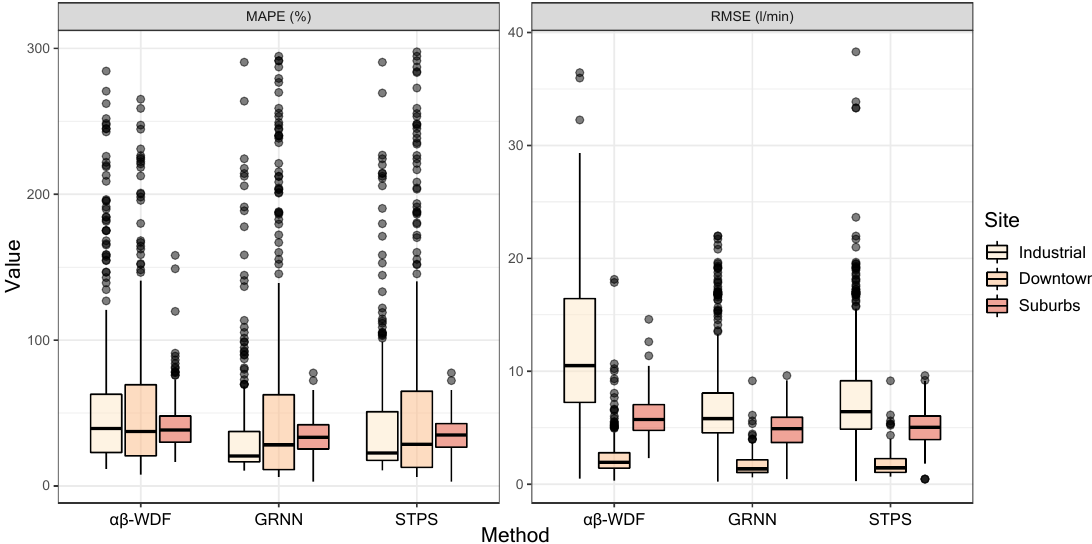
Figure 10. Boxplot of the goodness of fit parameter comparison among the αβ -WDF, GRNN, and STPS approaches for the three measured